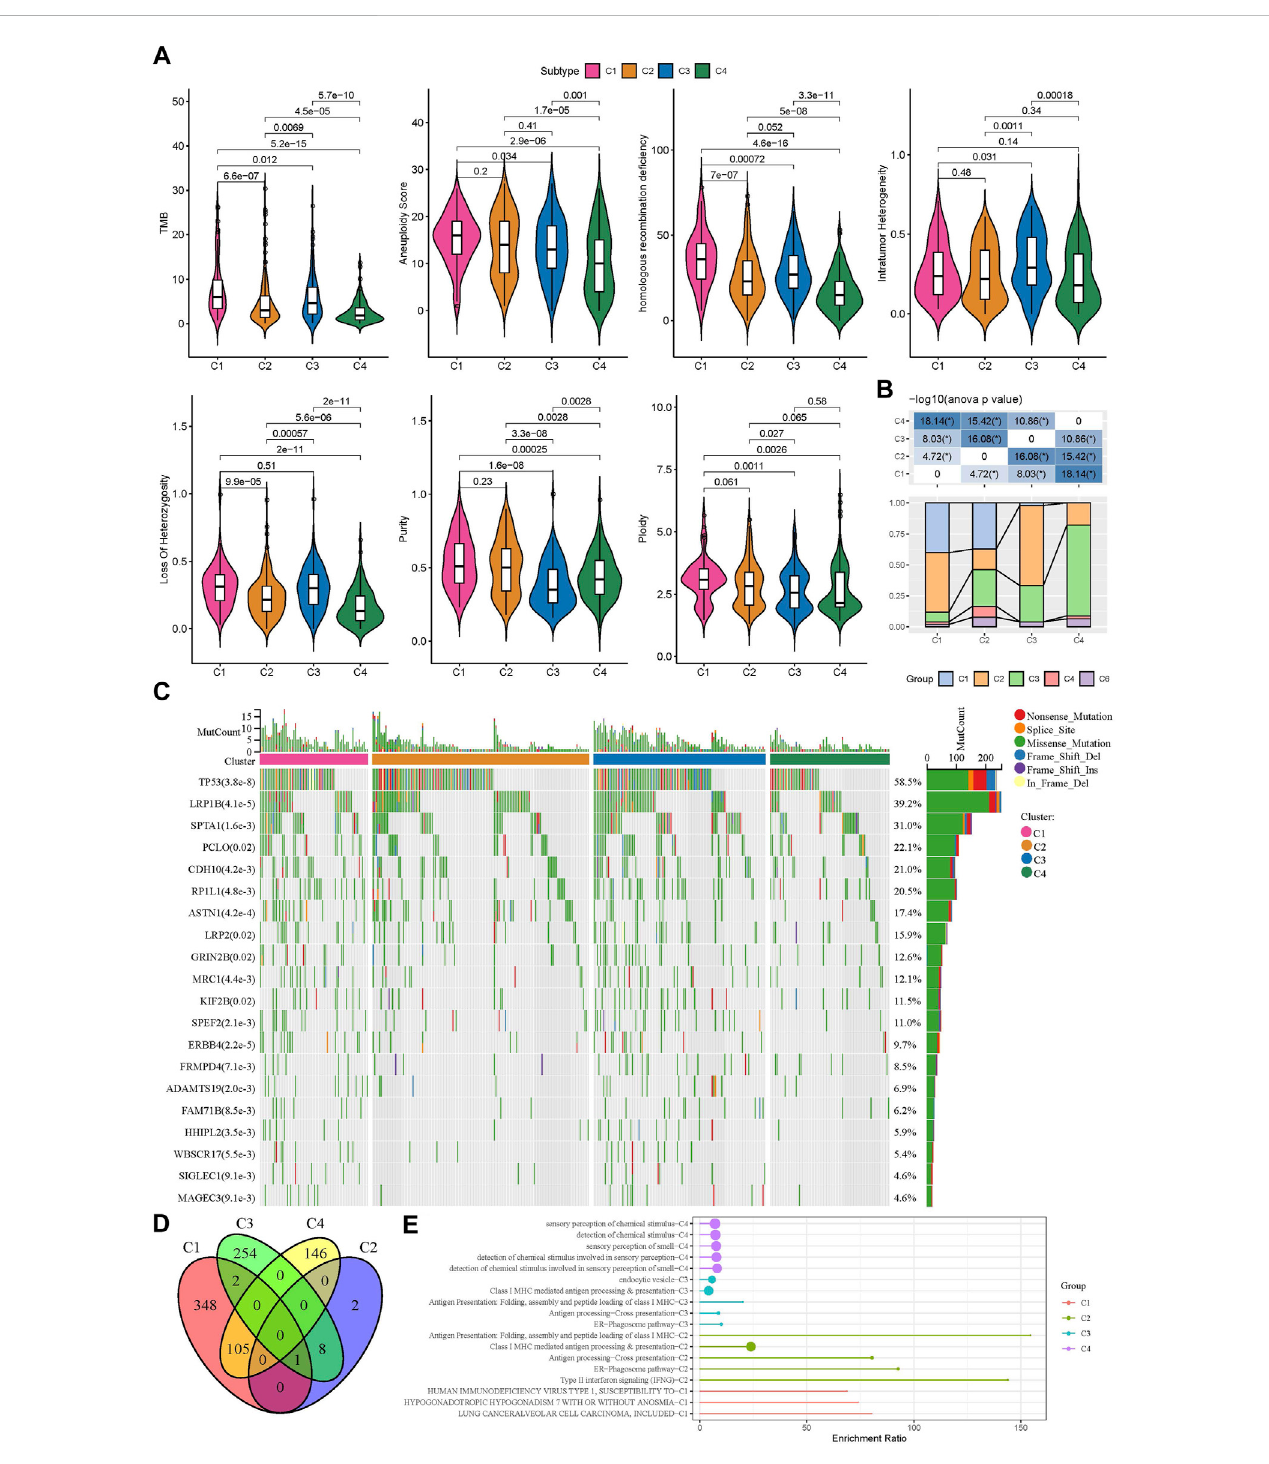
FIGURE 3 Gene mutations and genomic features of four subtypes in TCGA dataset (A) The score of TMB, aneuploidy, homologous recombination de fi ciency, intratumor heterogeneity, loss of heterozygosity, tumor purity, and ploidy in four subtypes (B) The distribution of previously reported immune subtypes (C1, C2, C3, C4, and C6) in TME-based subtypes (C) The top 20 mostly mutated genes in LUAD (D) Cross Venn Diagram of Different Methylation Sites of Each Subtype (E) Biological pathway of signi fi cant enrichment of methylation sites in different subtypes